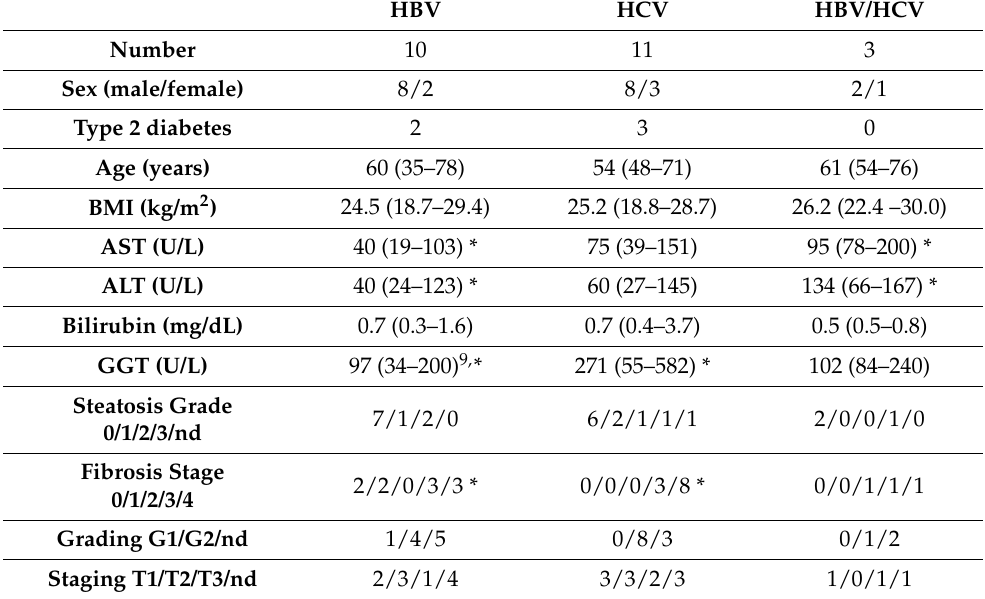
Table 3. Study group included patients infected with HBV, HCV or both viruses. GGT of 9 HBV infected patients was documented. This was indicated by an upper-case number. p < 0.05 between the two groups which were both labeled with *. Body mass index, BMI; alanine aminotransferase, ALT; aspartate aminotransferase, AST; gamma-glutamyl transferase, GGT, not defined, nd. HBV